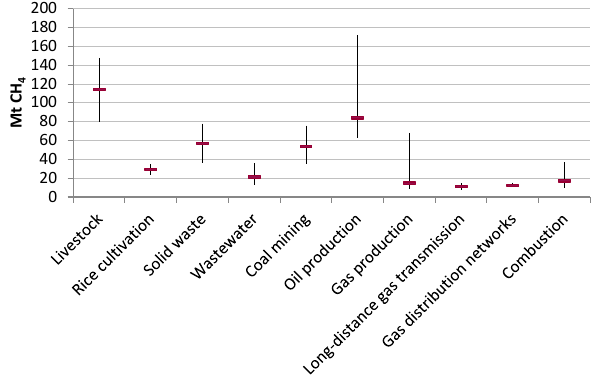
Fig. 10. Uncertainty ranges by sector for global CH 4 emission esti- mates in Baseline